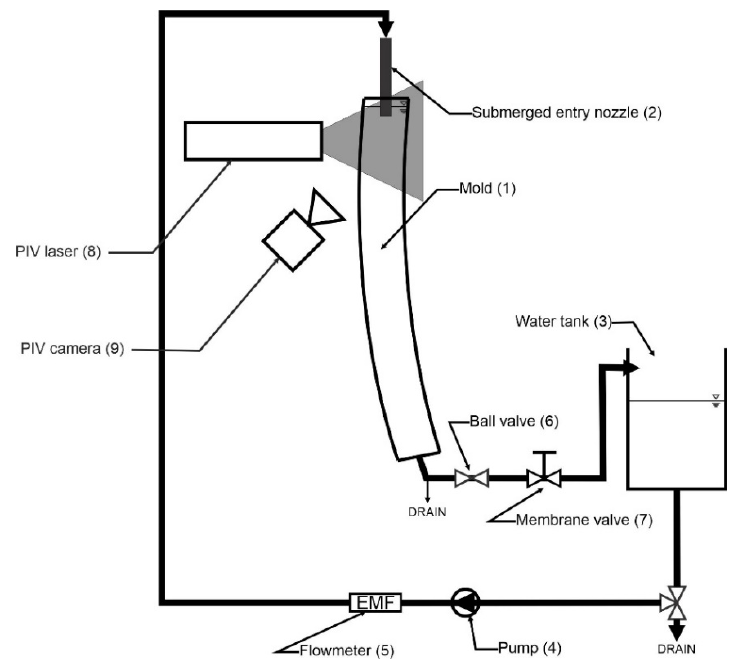
Figure 3. A schematic representation of the test